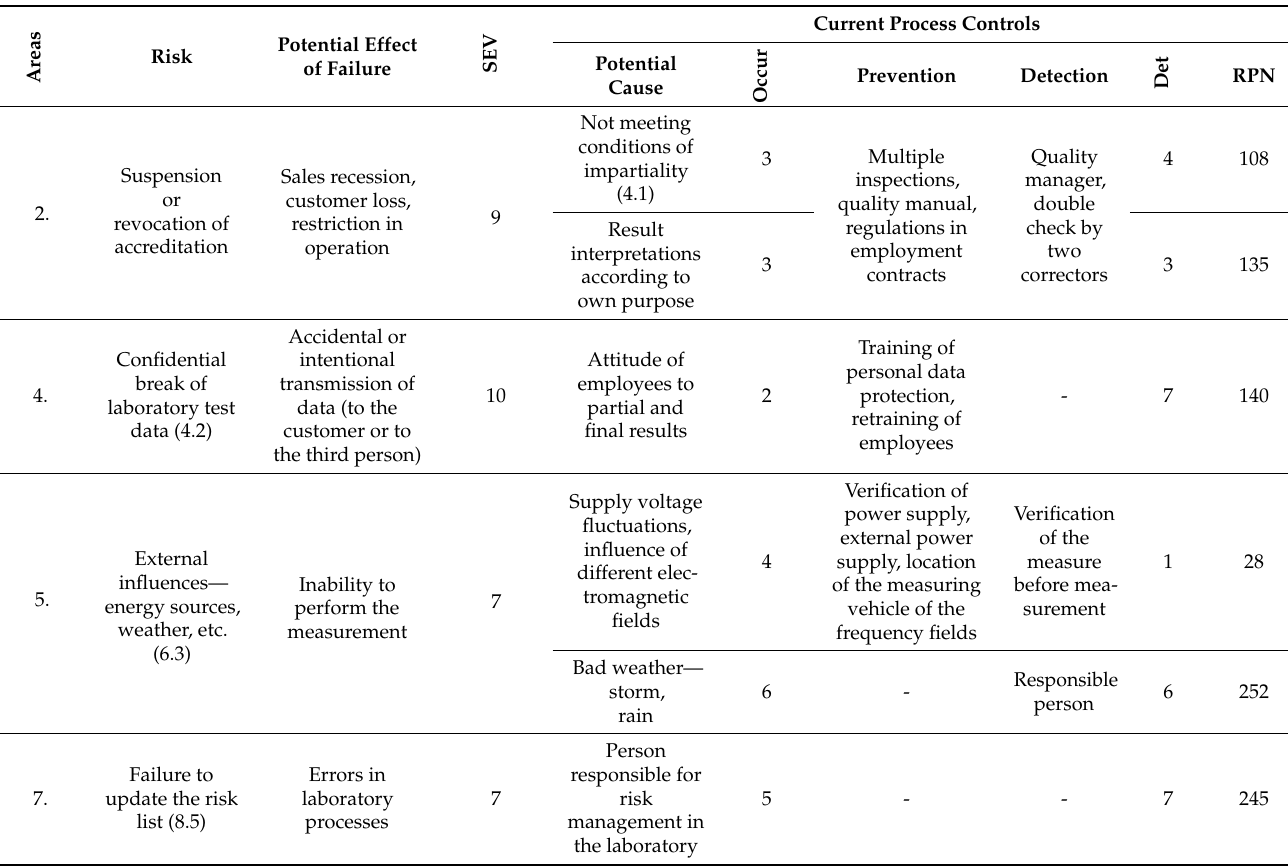
Table 5. FMEA—identification, analysis, risk